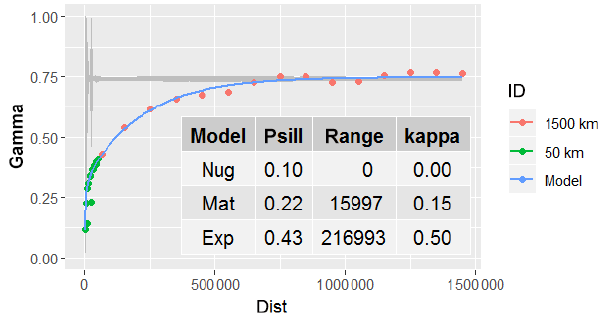
Figure 4. Model variogram (blue line; green dots are pairs of points up to a distance of 50km and red points up to 1500km) and 100 var- iograms from random permutations of the data (grey